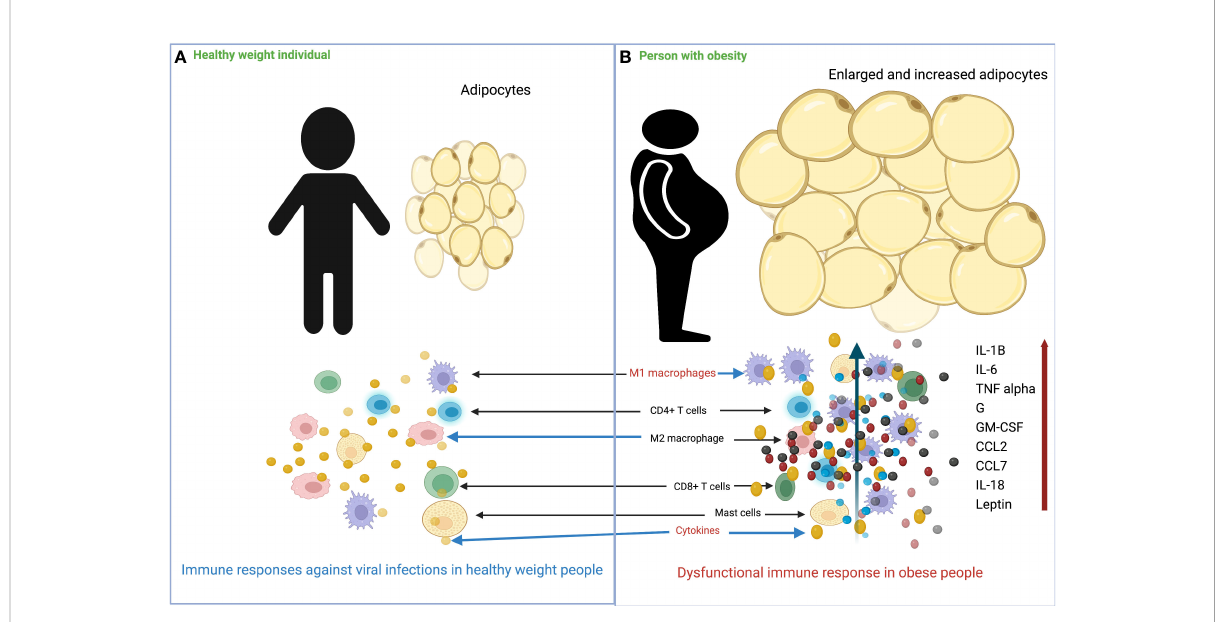
FIGURE 1 Overview of the differences in immune response to viral infection in healthy weight and obese individuals. (A) In healthy weight individuals, adipocytes are smaller and less numerous, and the immune system responds normally to viral infection. (B) In individuals with obesity, adipocytes increase in size and number, and there is massive in fi ltration of M1 macrophages into adipose tissue. Following viral infection, the immune system responds with impaired production of various